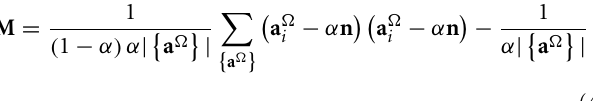
FIGURE 7 | Schematic of network. The vector v denotes the firing rates of all neurons in the network. For illustration, the activity and connections of the i th neuron are highlighted while those of two other neurons are displayed but